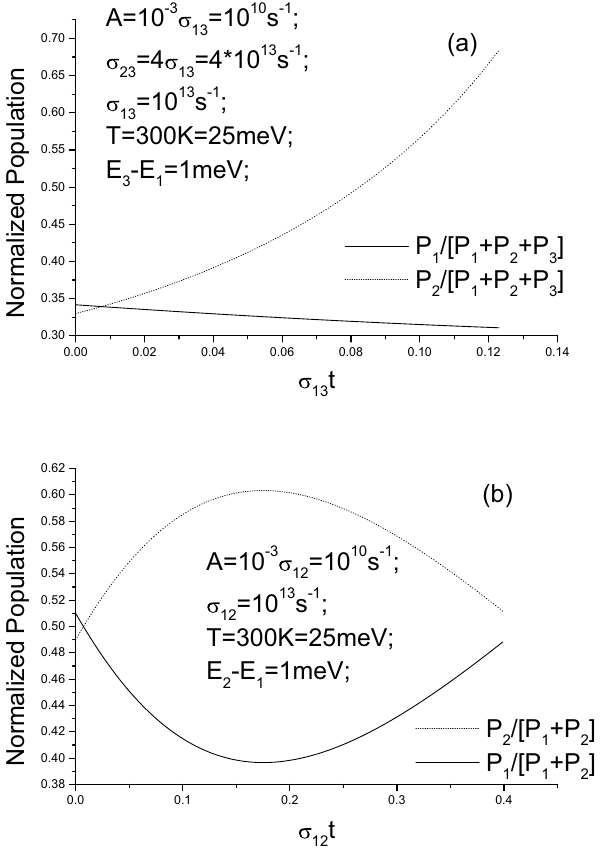
Figure 7. Examples of solutions of laser rate equations. ( a ) for 3-levels model and ( b ) for 2-levels